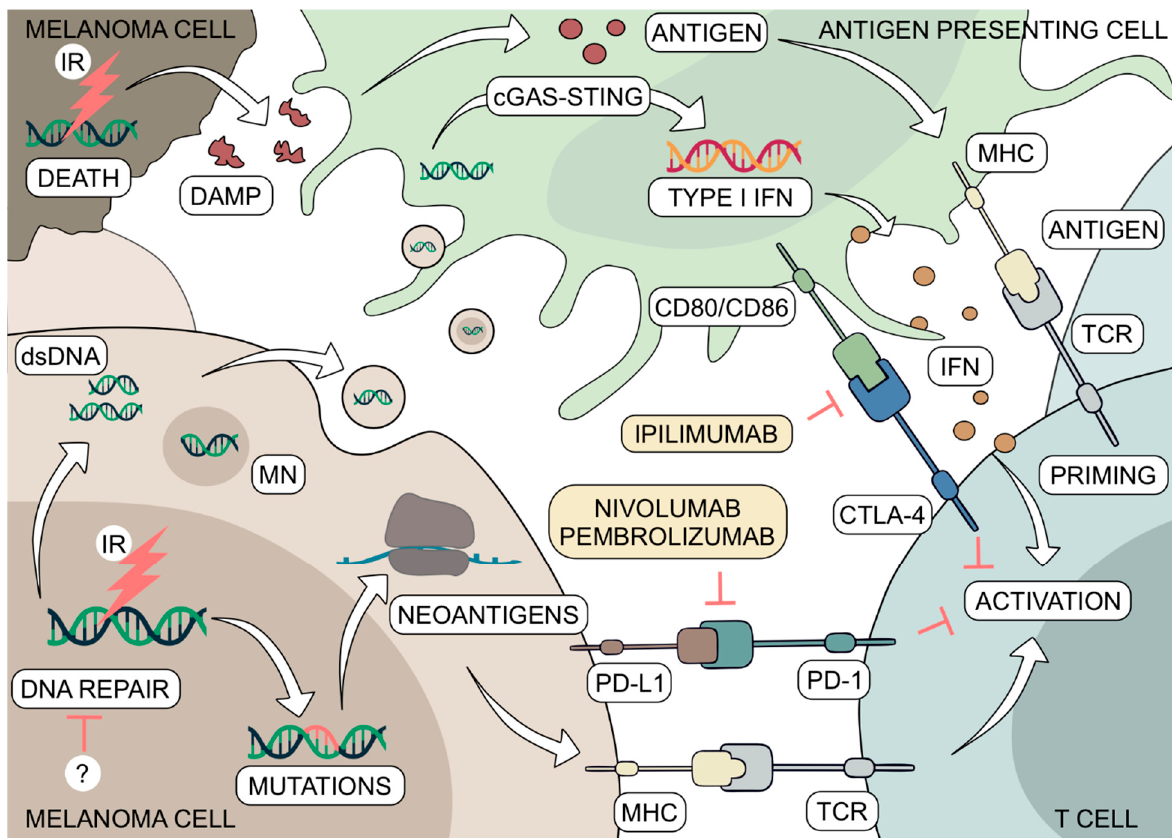
Figure 2. Mechanisms of irradiation-induced stimulation of immune system. Ionizing radiation (IR) leads to DNA lesions that may result in mutant proteins and neoantigen presentation via MHC molecule for T cells to recognize. IR-induced DNA damage may cause cytosolic DNA or micronuclei (MN) accumulation and secretion, which is taken up by antigen presenting cells, and leads to cGAS-STING pathway-mediated type I interferon production and secretion. Finally, severe damage by IR can cause cell death and release of DAMP molecules, which are processed by antigen presenting cells and presented to T cells leading to T cell priming. Immunoinhibitory interaction of PD-L1 expressed by melanoma cells with PD-1 present on T cells can be targeted with nivolumab and pembrolizumab, while CD80/CD86 and CTLA-4 interaction between antigen presenting cell and T cell can be inhibited by ipilimumab. Inhibitors of IR-induced DNA repair are likely to augment the genome destabilizing immunostimulatory effect of IR. Inhibitory effect is marked by red bar-headed